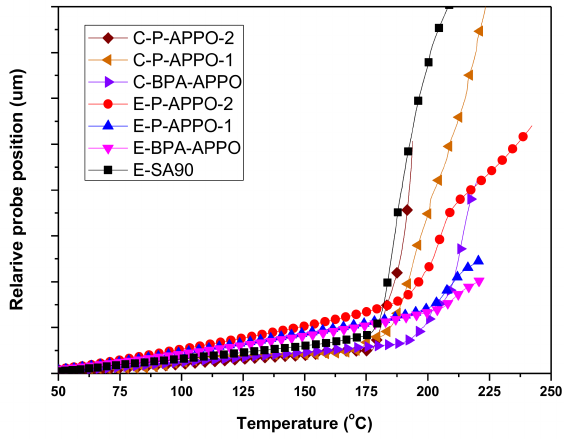
Figure 8. TMA thermograms of the prepared